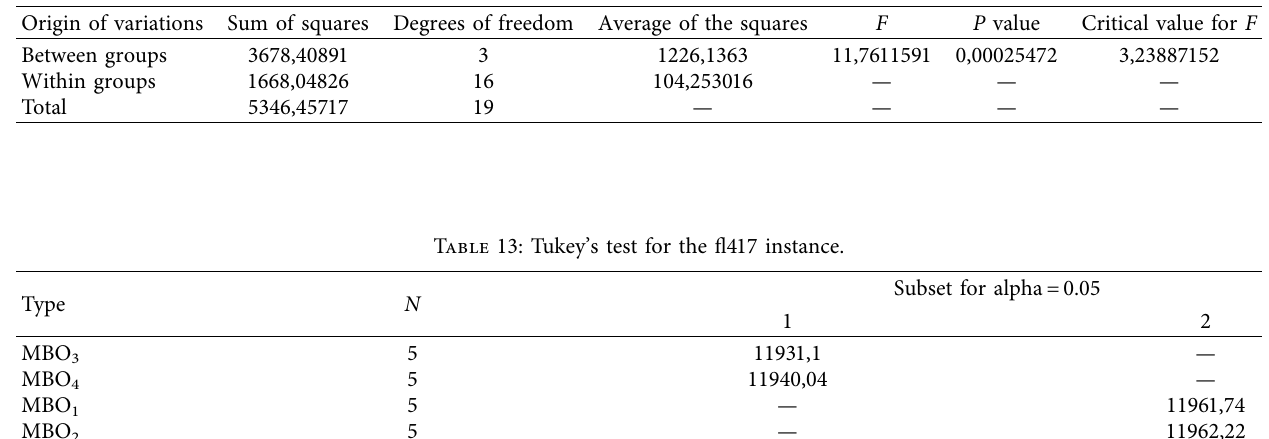
Table 12: ANOVA for the fl417 instance.